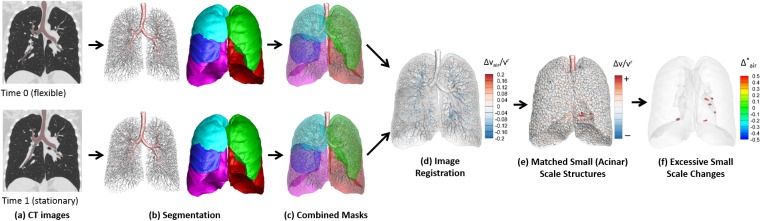
Schematic of flow chart to assess regional lung mechanics based on a pair of serial CT scans.